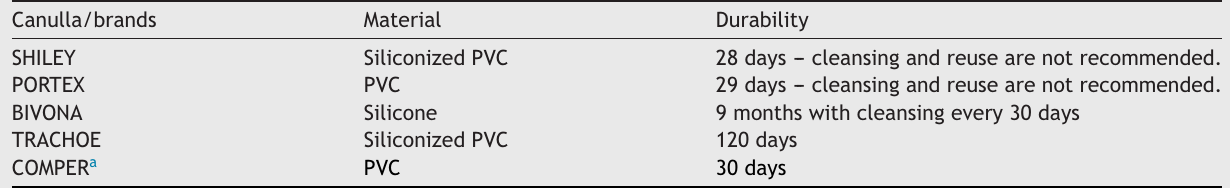
Description of the tracheostomy cannulas most frequently found in the national market with composition material and durability indicated in the package insert by the